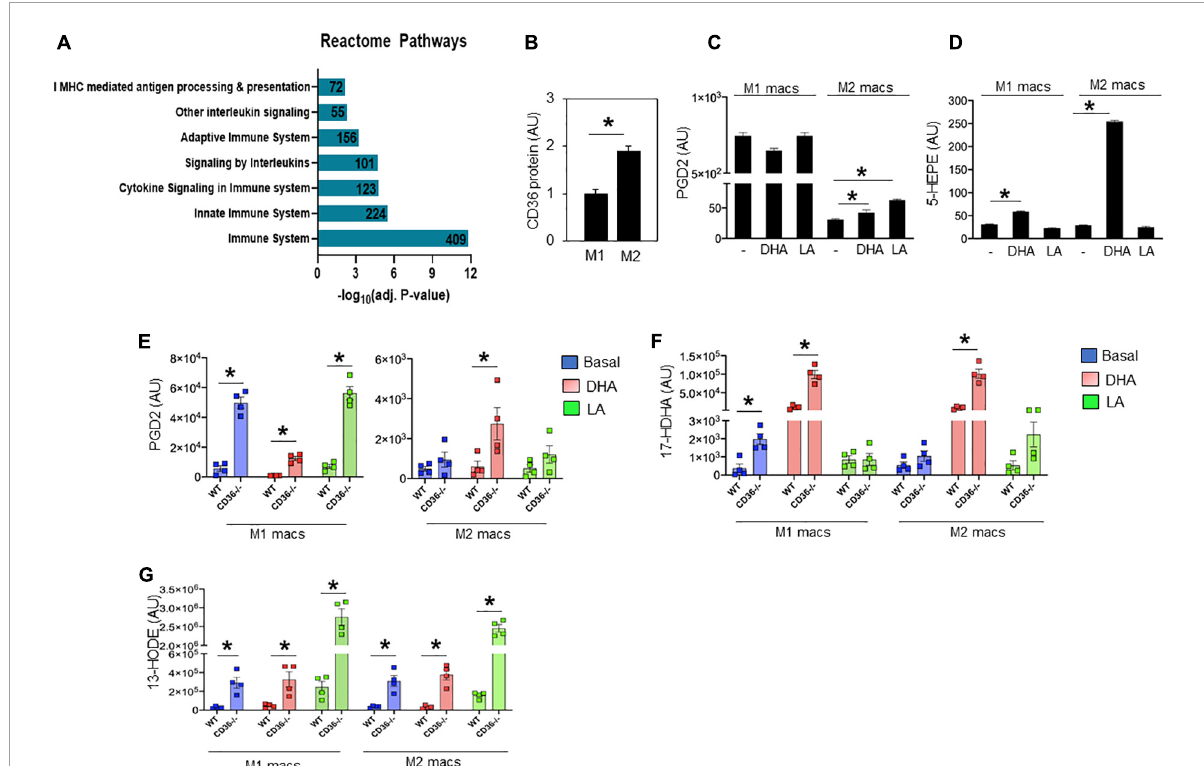
FIGURE4 CD36 deletion associates with markers of inflammation in heart tissue and isolated macrophages. (A) Microarray analysis in CD36 − / − heart shows upregulated biological pathways involved in immune cell activation and inflammation ( n = 3/group). Pathway analysis obtained from Reactome analysis database using differentially regulated genes ( > 1.6 or < 0.7). Number of differentially regulated genes is indicated on the significance bar for each pathway. (B) WT bone marrow-derived macrophages (BMDM) were subjected to a polarization protocol to yield M1- and M2-like macrophages and were assayed for CD36 expression levels by western blotting. WT M1- and M2-like macrophages were assayed for the content of (C) PGD2 and (D) 5-HEPE at baseline and following DHA or LA treatment. (E–G) BMDM were obtained from WT or CD36 − / − mice and subjected to the polarization protocol. M1- and M2-like macrophages were then treated with DHA or LA to measure the content of (E) PGD2, (F) the DHA metabolite 17-Hydroxy-ocosahexaenoic acid (17-HDHA) and (G) the linoleic acid metabolite 13-Hydroxyoctadecadienoic acid (13-HODE). Eicosanoids were measured by LC–MS. All data ( n = 4/group) are means ± SE with n representing the number of mice per group. Statistical significance is determined by Student’s t test. * p <